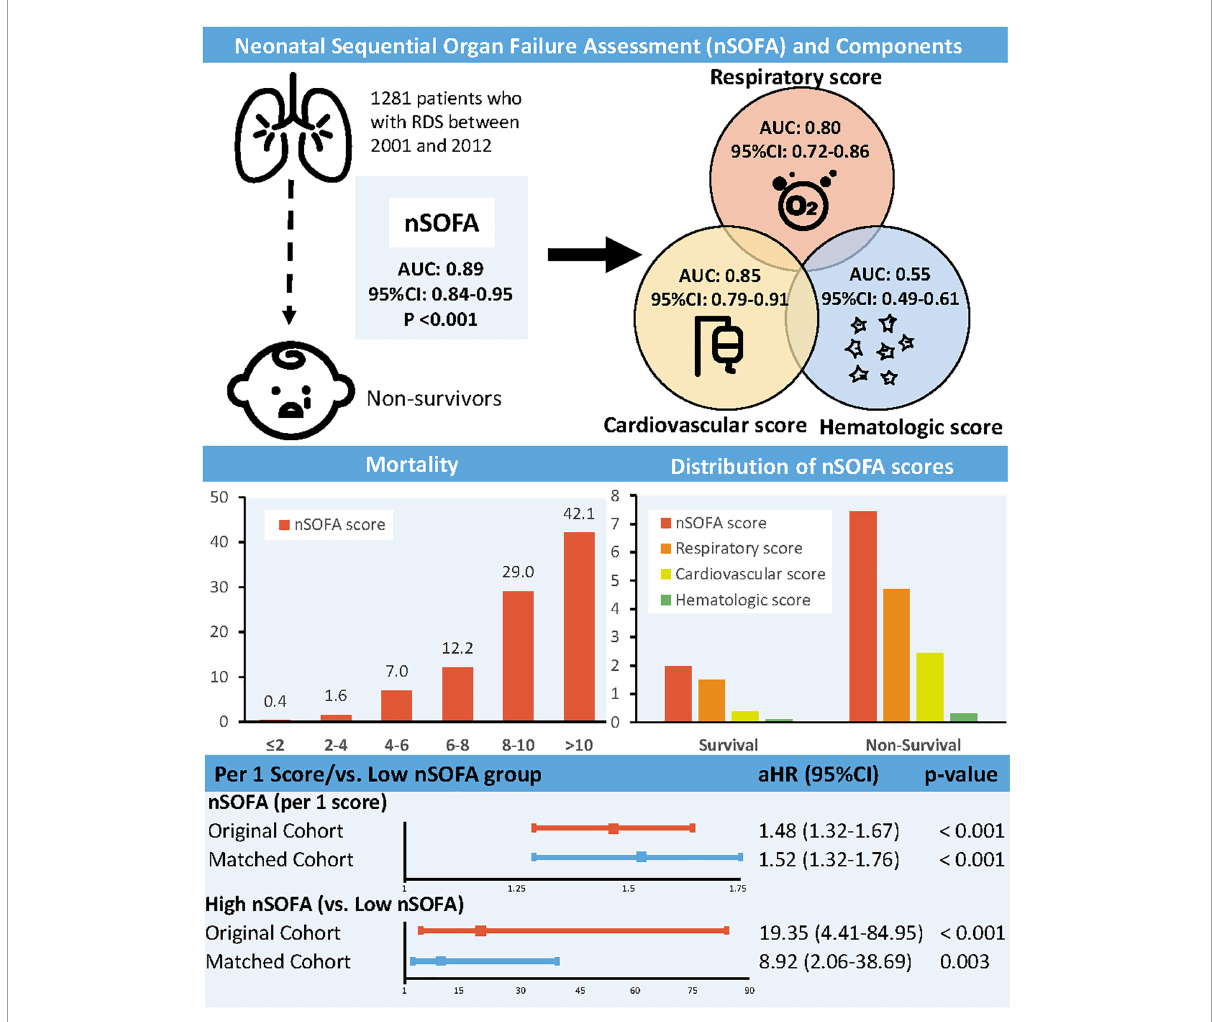
FIGURE1 Association between neonatal sequential organ failure assessment and mortality. nSOFA, neonatal sequential organ failure assessment; RDS, respiratory distress syndrome; AUC, area under curve; CI, confidence interval; HR, hazard